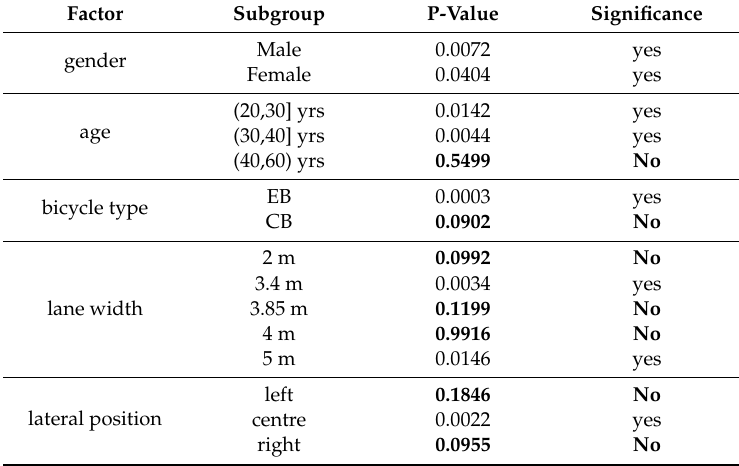
Table 6. Results of Parameter Estimating and Goodness of Fit for Generalized Linear Model (significance level =